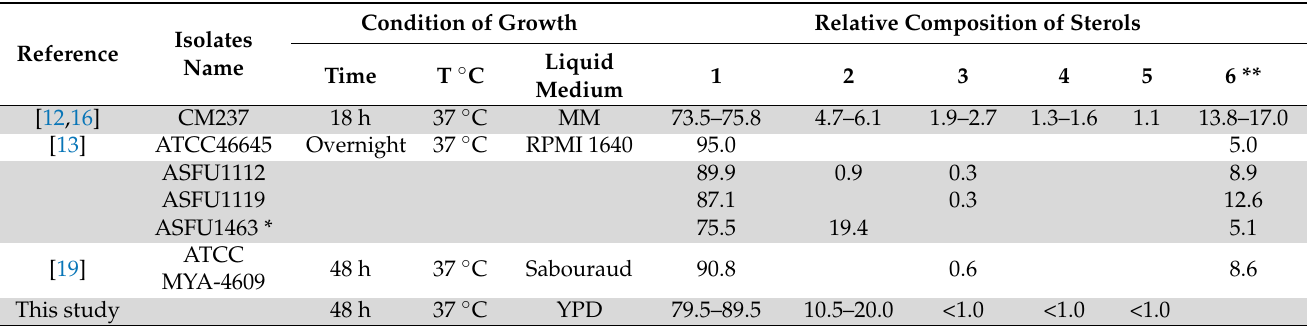
Table 7. Comparison of basal relative (%) composition of sterols of six WT strains of A. fumigatus published between 2001 and